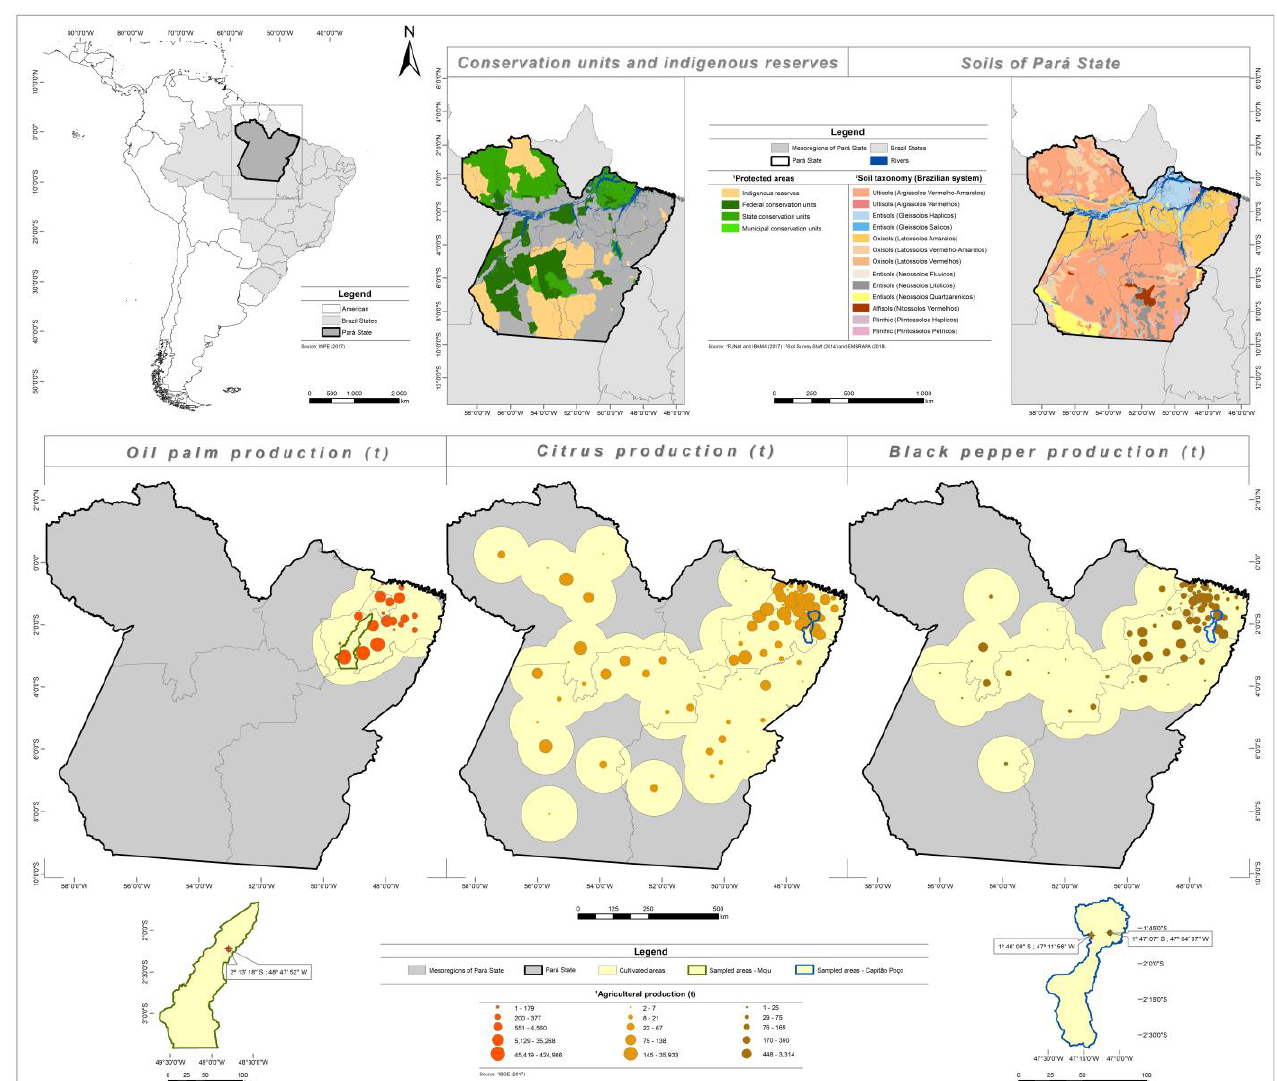
Figure 1. Study site and sampling of Oxisols and Ultisols from the state of Pará, Brazil.